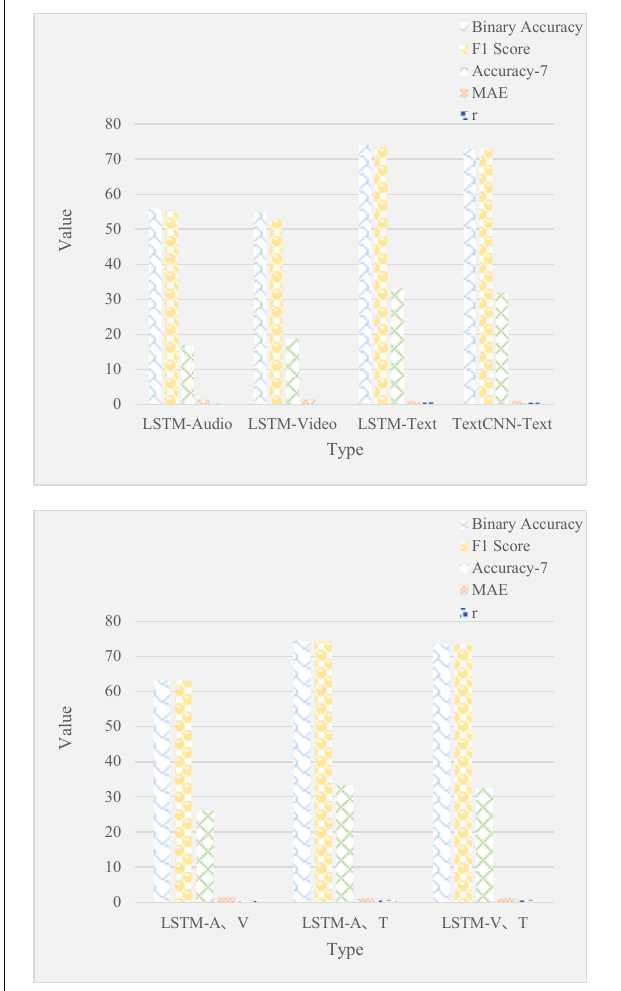
FIGURE 8 | Single-modal and bi-modal emotion recognition (ER) results in MOSI dataset.